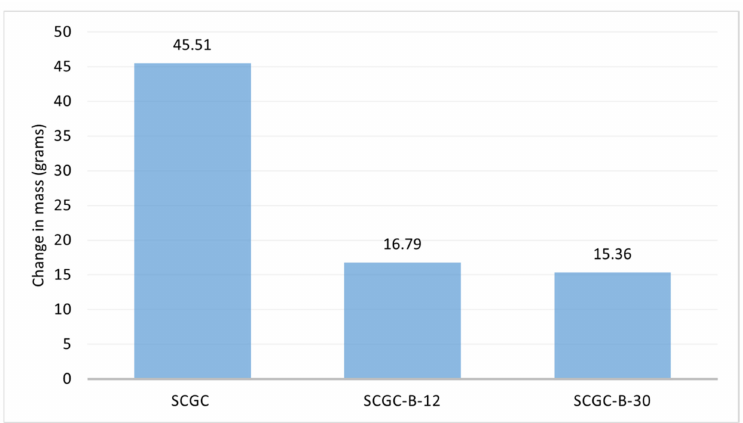
Figure 14. Mass change of SCGC, SCGC with 12 mm basalt fibres, and 30 mm basalt fibres until